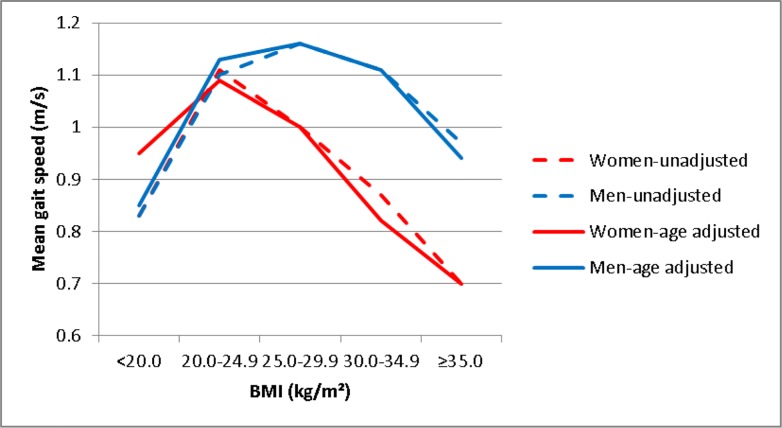
Association between gait speed and BMI.Red lines represent women. Blue lines represent men. Dashed lines show unadjusted results. Continuous lines show age-adjusted results.